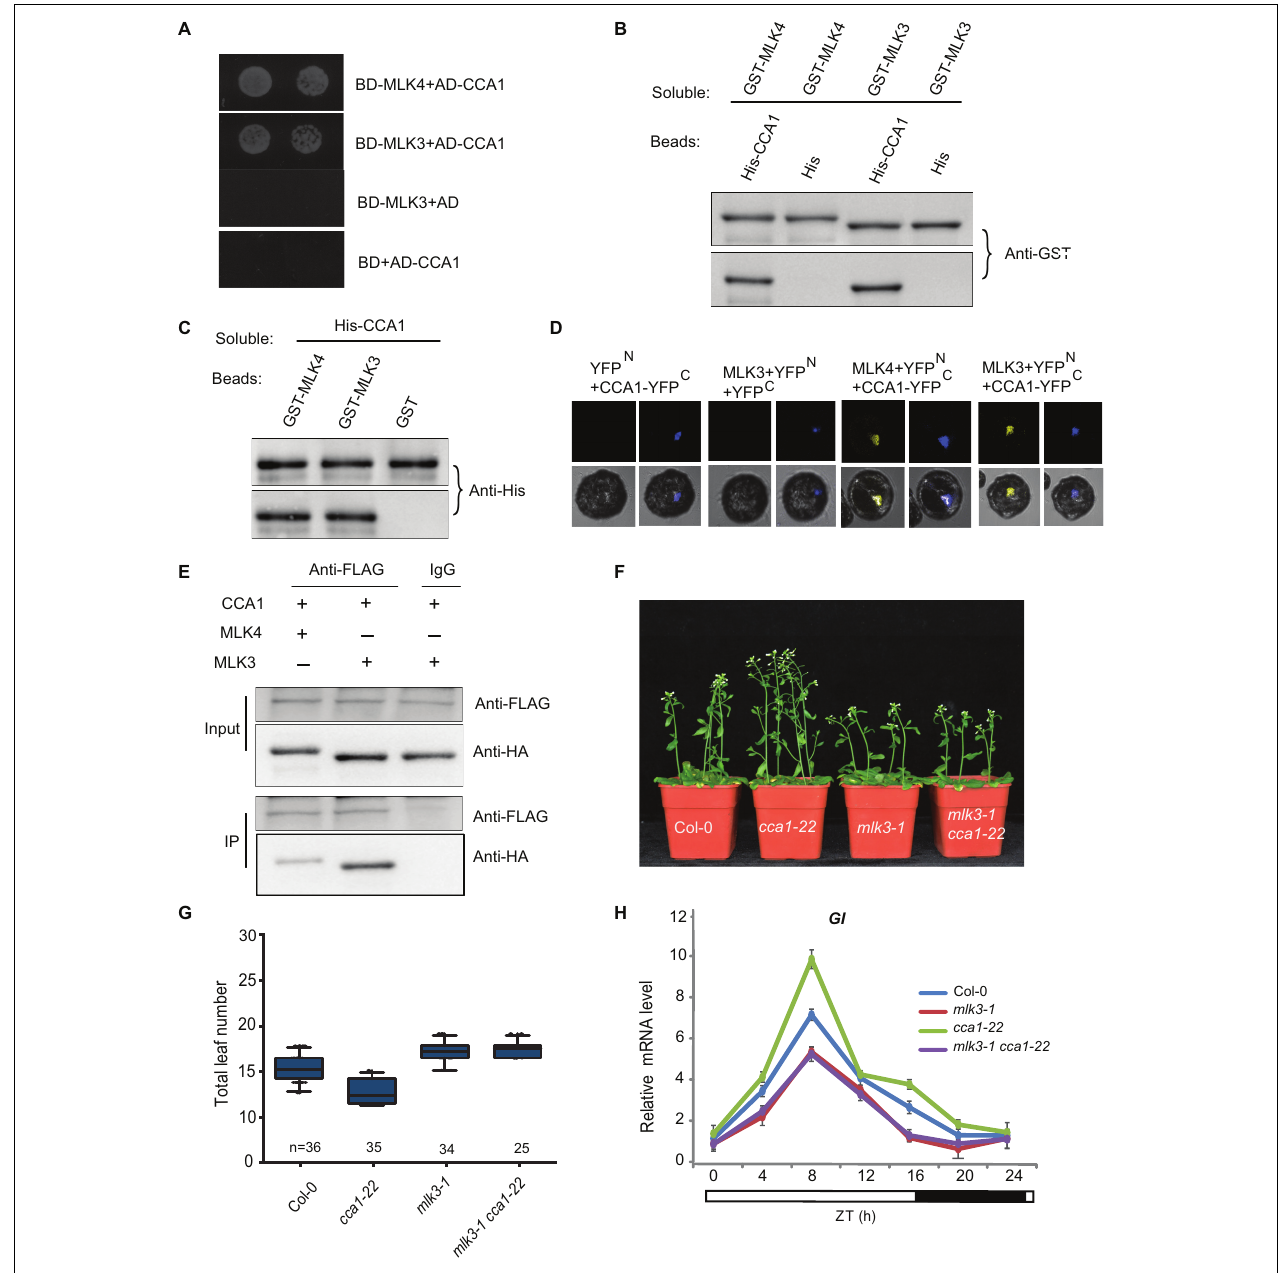
FIGURE 5 | MLK3 interacts with CCA1 in vitro and in vivo . (A) A yeast two-hybrid assay revealed an interaction between MLK3 and CCA1. The growth of two dilutions (2 × 10 − 2 and 2 × 10 − 3 ) of the yeast culture on SD medium lacking Trp, Leu, His, and adenine is shown. (B) Beads containing a His-fused CCA1 were assayed for their ability to bind to soluble GST-fused MLK3. The input and bound proteins were detected with an antibody to GST (anti-GST). MLK4 was used as positive control, and His alone was used as negative control. (C) Beads containing a GST-fused MLK3 were assessed for their ability to bind to soluble His-fused CCA1 and detected with antibody to His (anti-His). (D) Either MLK3 fused to the N terminus of YFP or the N terminus of YFP alone was tested for their ability to bind to the C terminus of YFP fused to C terminus of YFP fused to CCA1. Yellow fluorescence and a bright-field image were recorded and the resulting images were merged. Twenty-five cells were examined for each transformation. Bar = 10 µ m. (E) Co-immunoprecipitation of MLK3 and CCA1. FLAG-CCA1 and HA-MLK3 were cotransformed into Arabidopsis protoplasts, and the expressed proteins were immunoprecipitated using an anti-FLAG antibody, and detected with anti-Flag and anti-HA. In panels (A–E) , experiments were repeated at least three times, and representative experiments are shown. (F) The representative phenotype of Col-0, mlk3-1 , cca1-22 , and mlk3-1cca1-22 plants under a LD photoperiod. (G) The total leaf number of Col-0, mlk3-1 , cca1-22 , and mlk3-1 cca1-22 plants under a LD photoperiod. Values shown are mean ± SD of total leaves; At least 25 plants were scored for each line. Asterisks indicate P < 0.05 and ns indicates no significance by t -test. (H) The transcript levels of GI were examined in Col-0, mlk3-1 , cca1-22 , and mlk3-1 cca1-22 mutants. The white bar indicates the light periods, and the black bar indicates the dark period. ZT, Zeitgeber time. Experiments were repeated at least three times, and the representative experiments shown indicate the mean ± SE, n = 3 replicates.